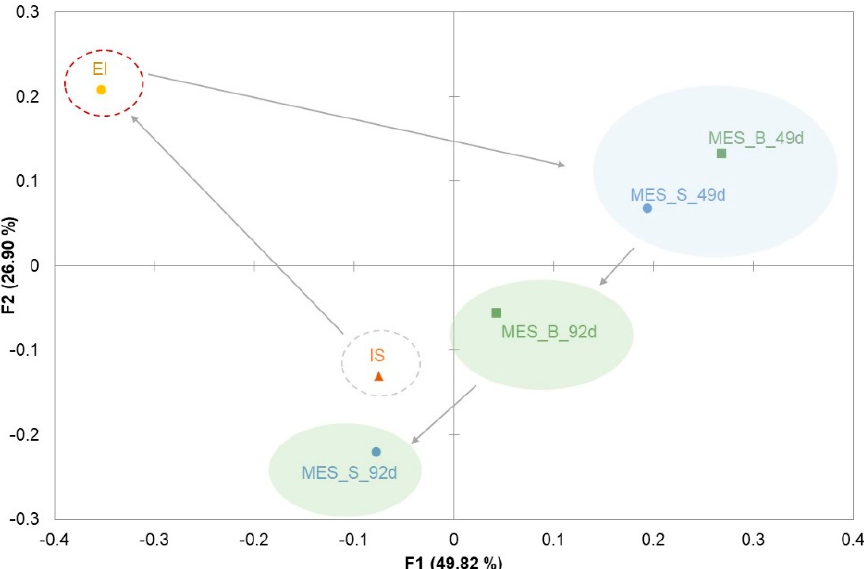
Figure 4. Principal component analysis (PCA) of eubacterial communities based on the operational taxonomic unit (out) matrix. Microbial communities from the initial sludge (IS), enriched inoculum (EI), and samples from biofilm (B) and supernatant (S) taken during the experiment.